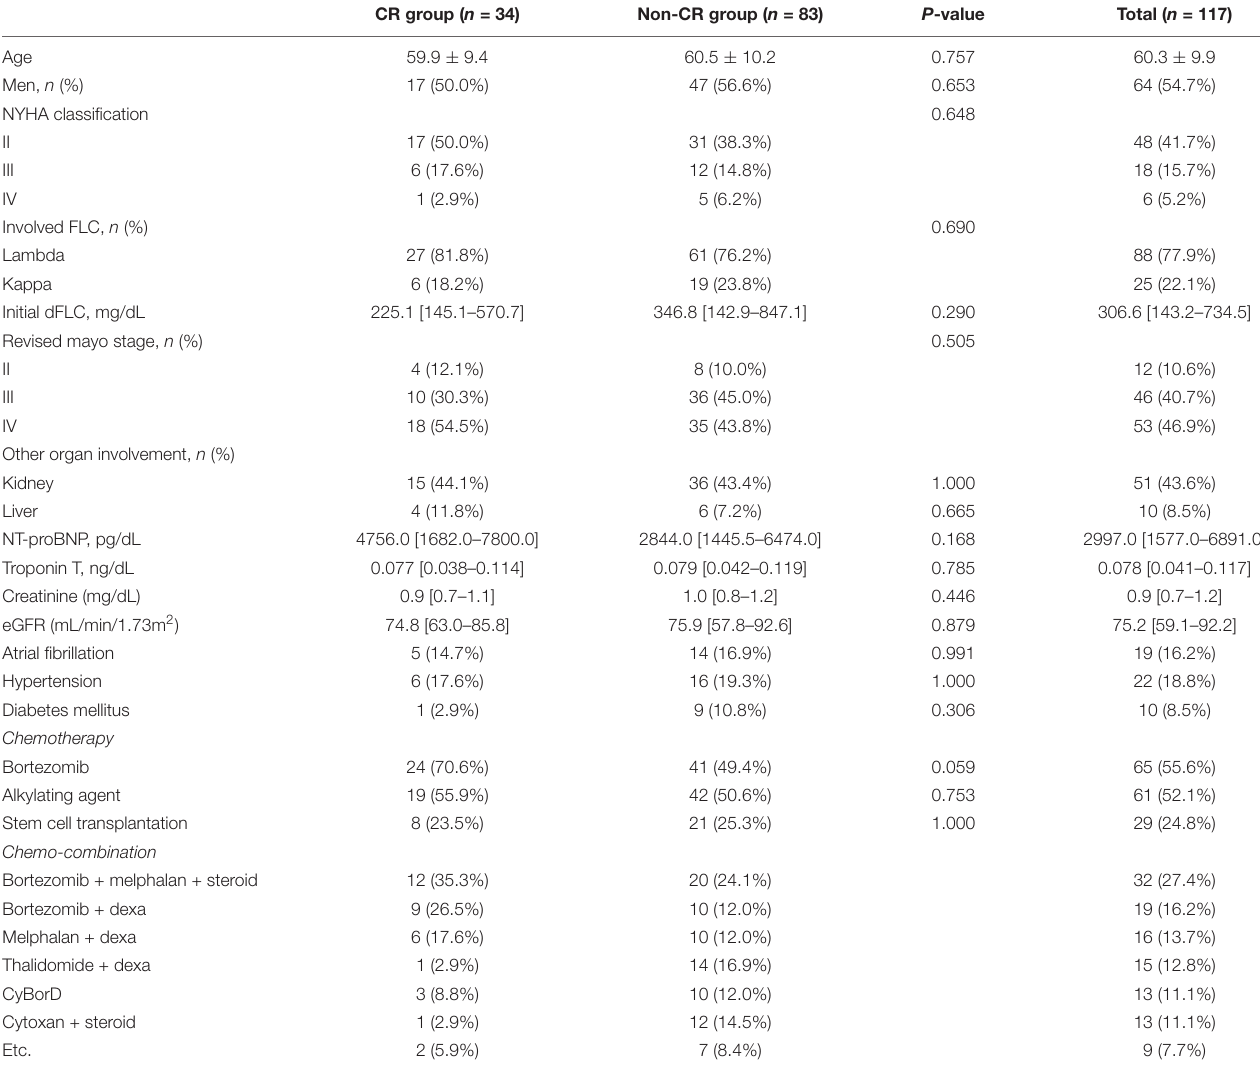
TABLE 1 | Comparison of baseline characteristics between CR and non-CR